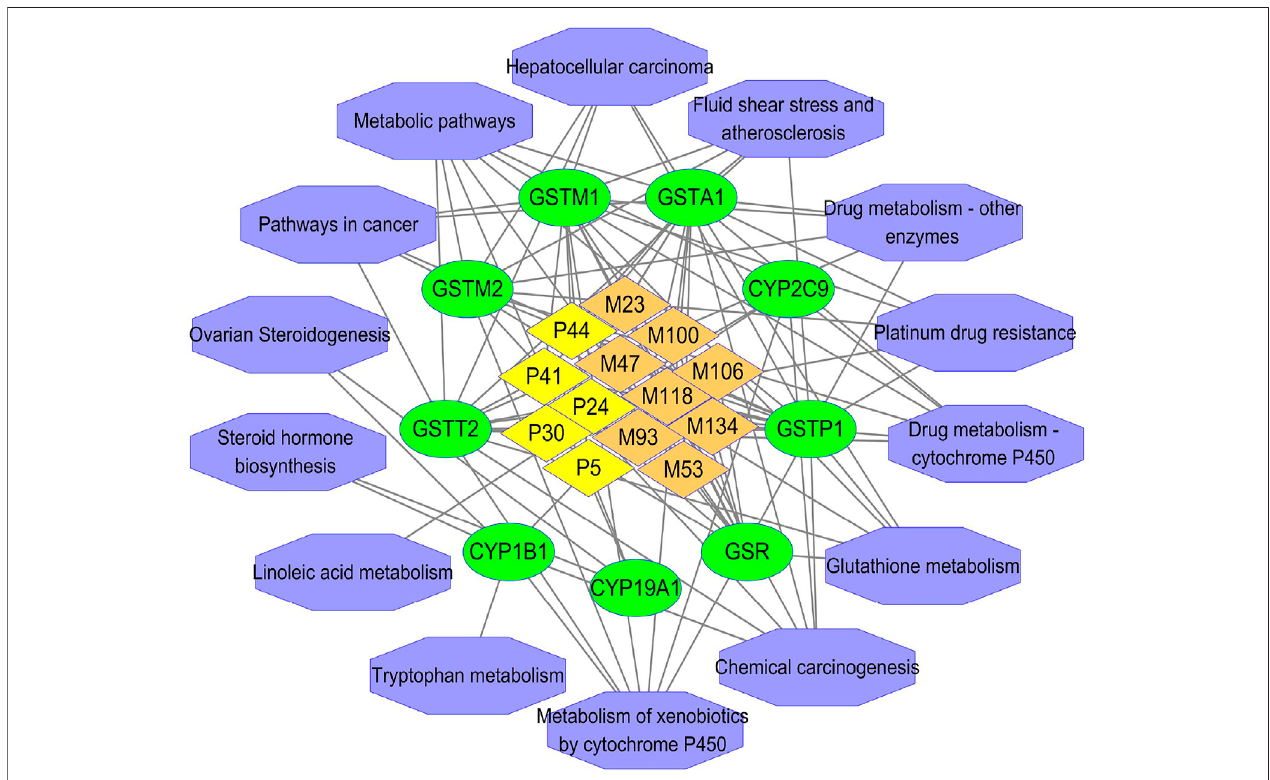
FIGURE 7 | The “ compound-target-signaling pathway ” network. The yellow, orange, green and purple represented prototypes, phase Ⅰ metabolites, the corresponding key targets and signaling pathways, respectively.